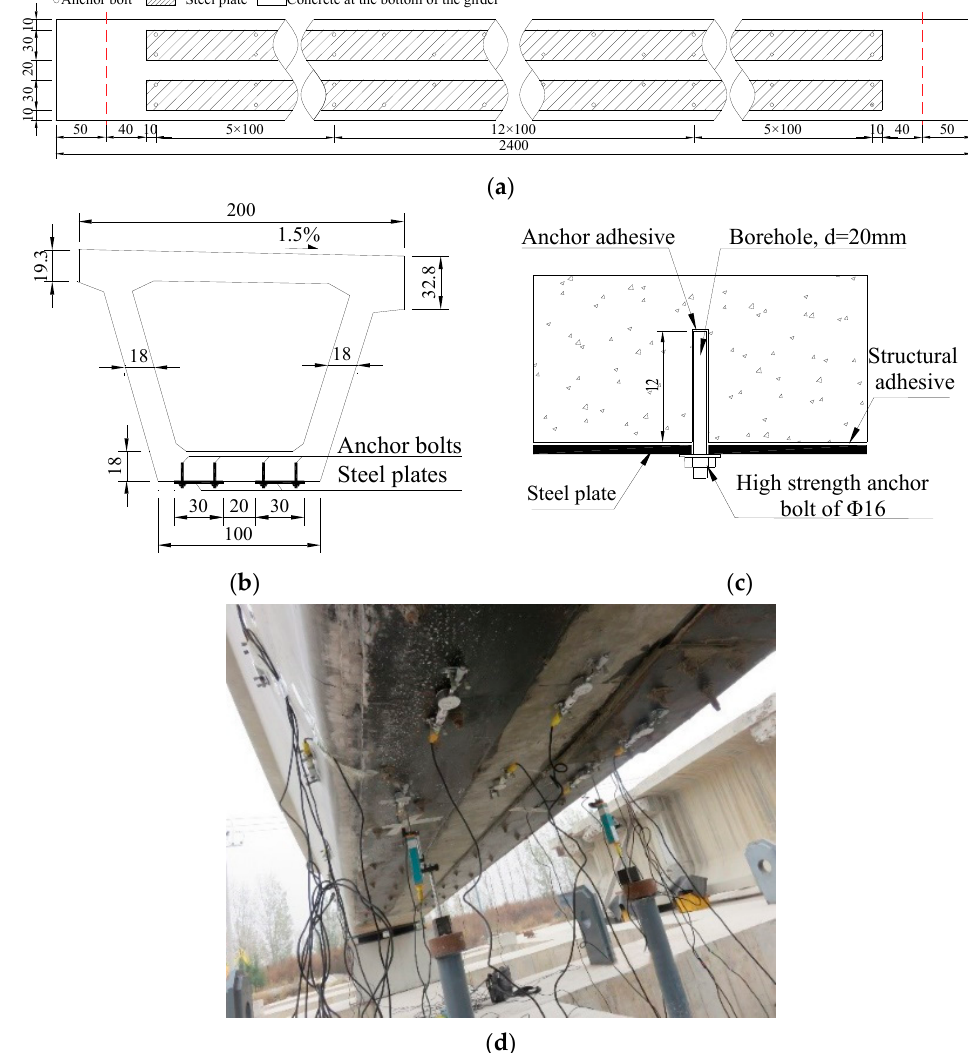
Figure 7. Layout of steel plates. ( a ) Layout at the bottom of the girder (Unit: cm); ( b ) Cross-sectional view of the steel plates layout (Unit: cm); ( c ) Details of the layout of steel plates; ( d ) Actual steel plates at the bo tt om of the girder.